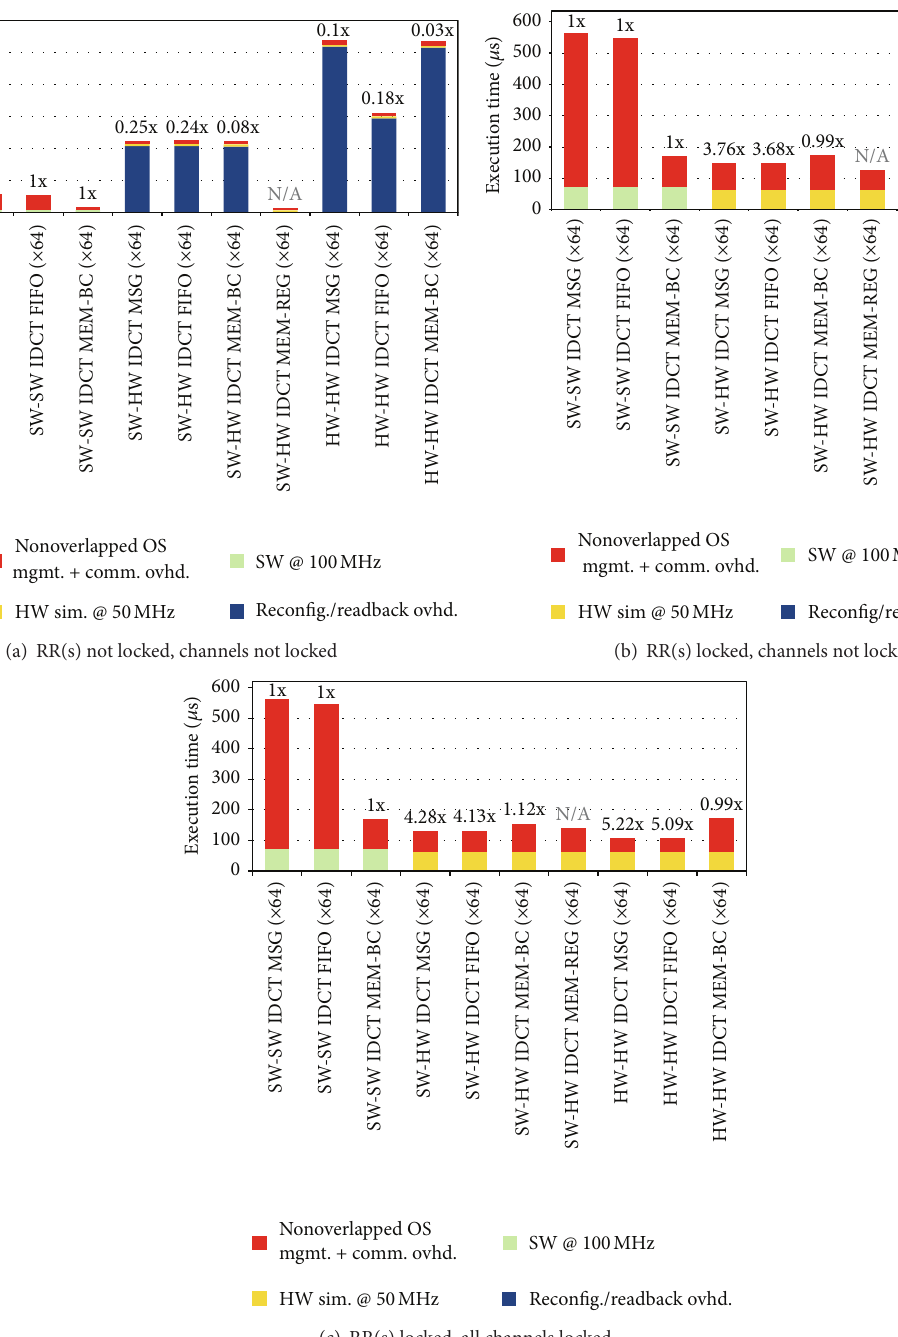
Figure 25: HW versus SW processing speedups for